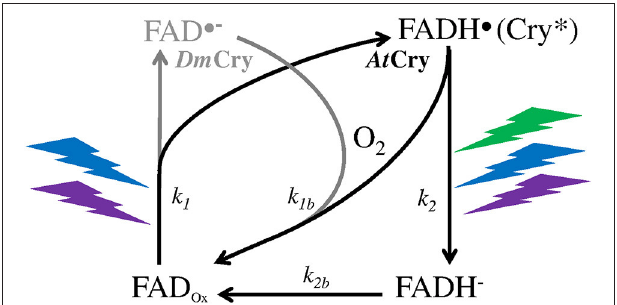
FIGURE 1 | Photocycle of the FAD cofactor of the Cry protein of the plant Arabidopsis thaliana ( At Cry, in black) (Procopio et al., 2016) and of the fruit fly Drosophila ( Dm Cry, in gray) (Arthaut et al., 2017). Under exposure to light (350–500nm, UVA to blue), the oxidized form of At Cry is readily reduced. The radical form (neutral in At Cry, anionic in Dm Cry) that results from this step is the active one (Cry*). The binding of that form with signaling partners causes its phosphorylation and subsequent proteolysis. In Dm Cry, FAD •− undergoes direct reoxidation with dioxygen. In At Cry, FADH • is either directly reoxidized or fully reduced by light (350–580nm, UVA to green) and further reoxidized.